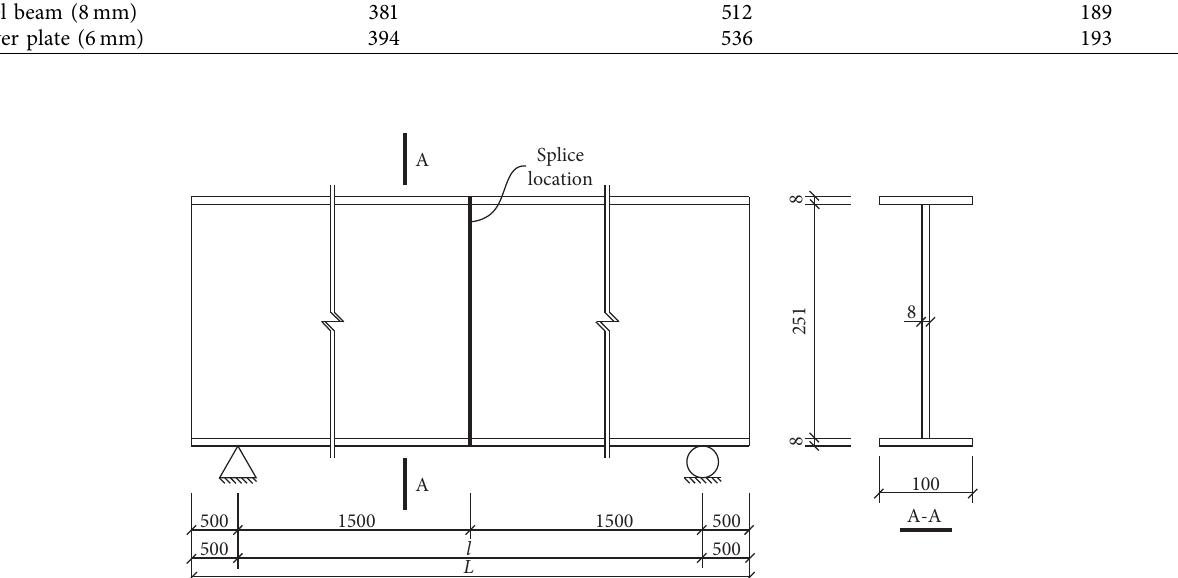
Figure 2: Dimension of specimens.